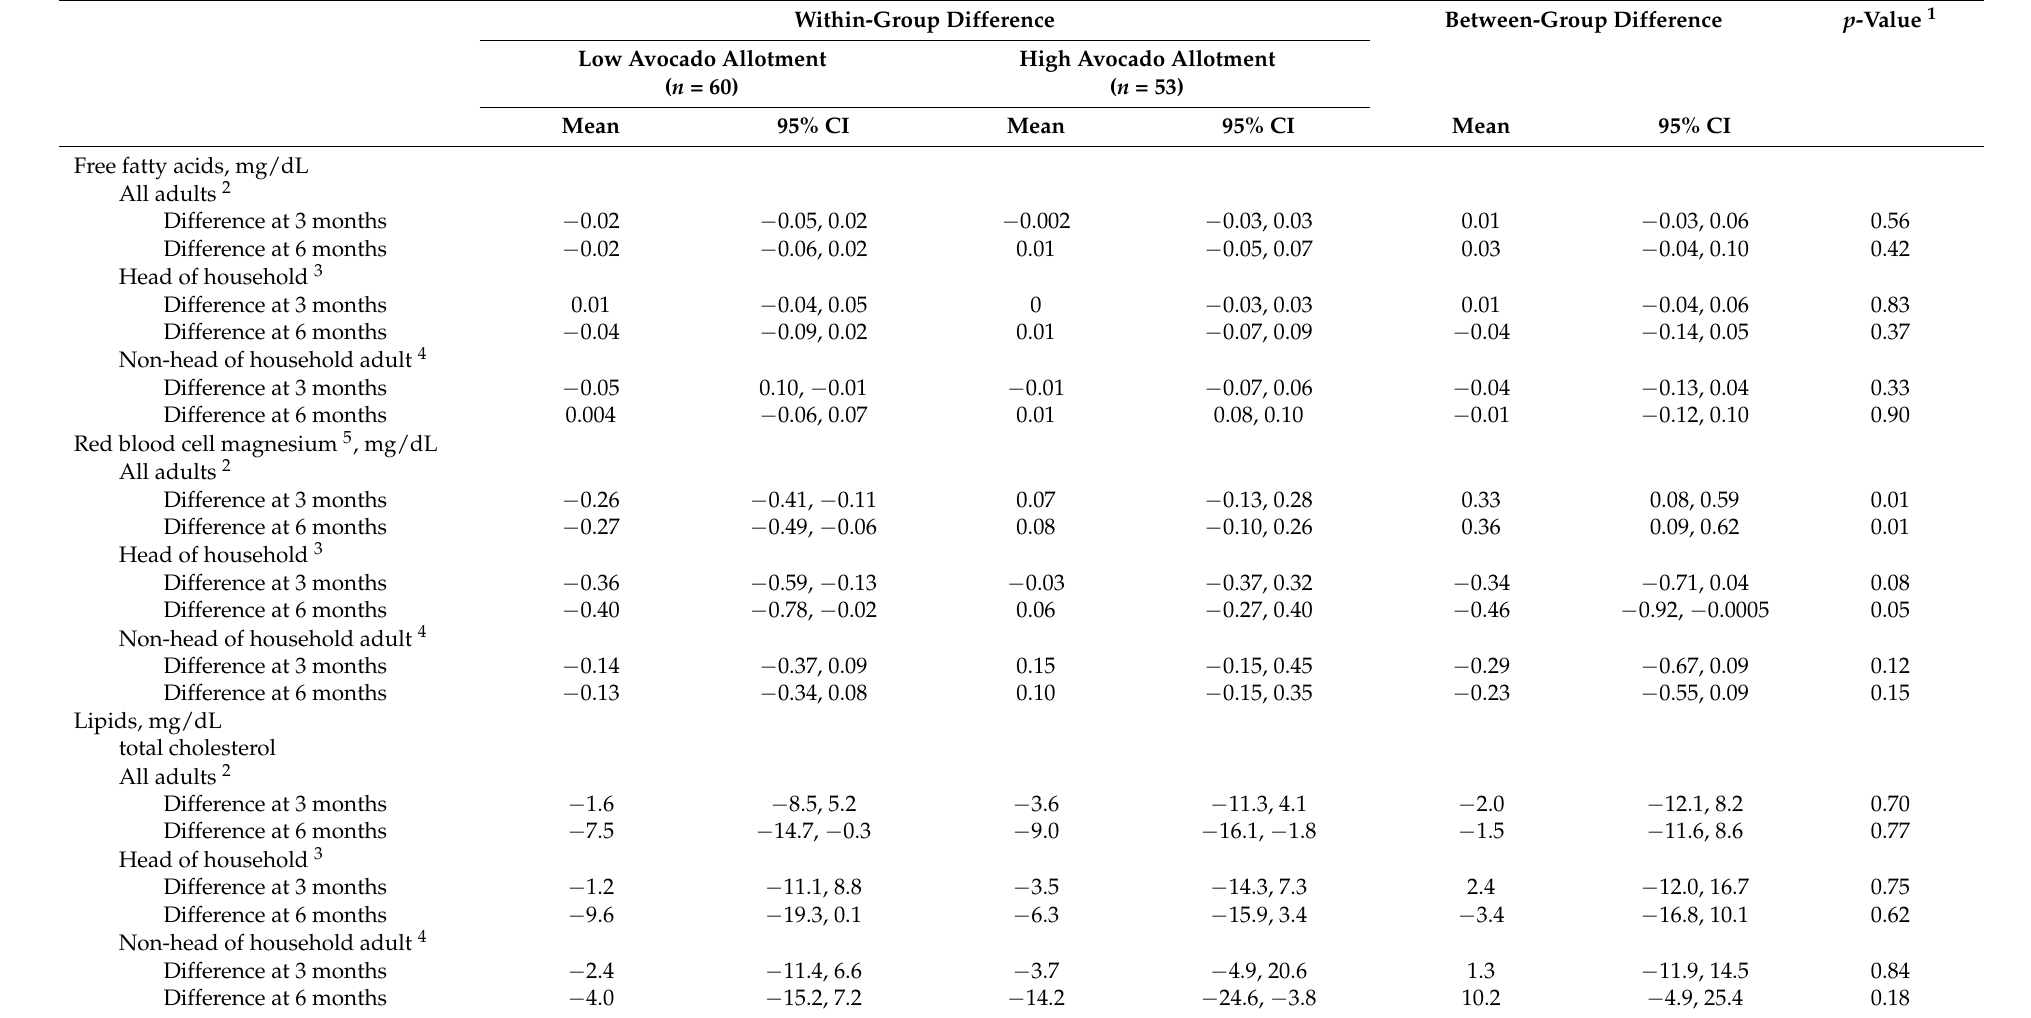
Table 6. Changes in free fatty acids, magnesium, lipids, glycemia markers, and c-reactive protein in adults, per intention-to-treat analysis in the Effects of Avocado Intake on the Nutritional Status of Families Trial ( n =